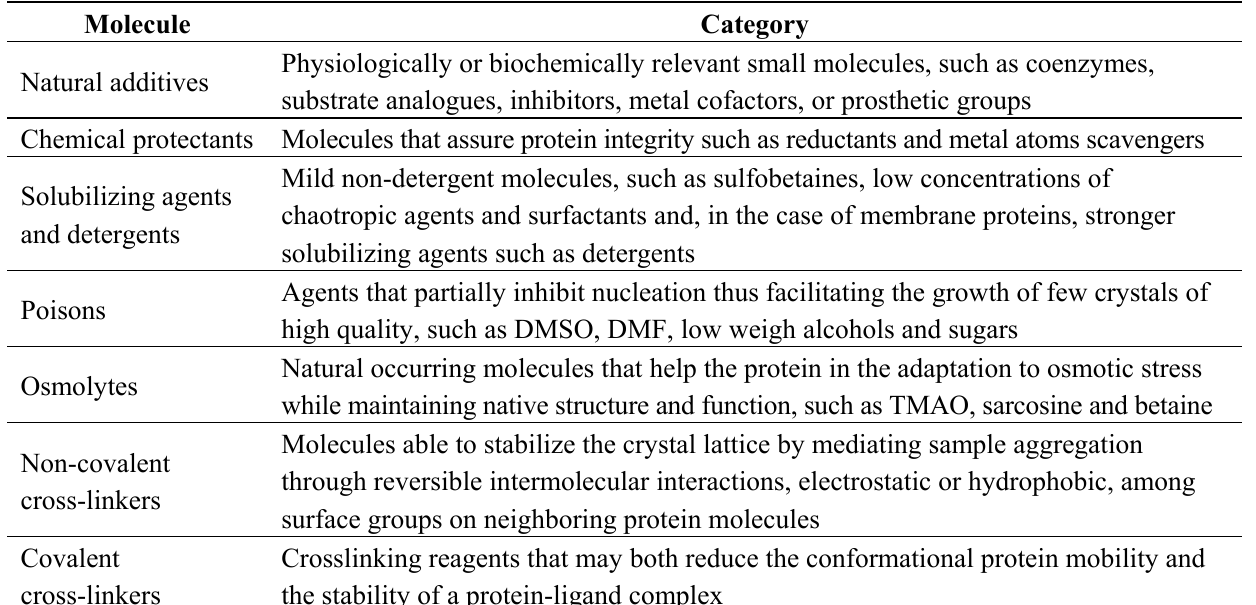
Table 3. Classification of additives according to McPherson et al.